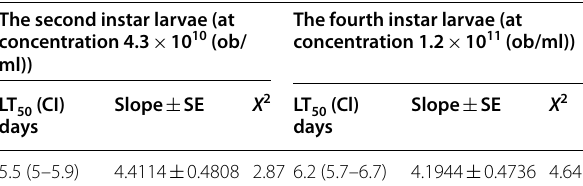
) of Spodoptera littoralis 50 10 10 and 1.2 10 11 ob/ × ×